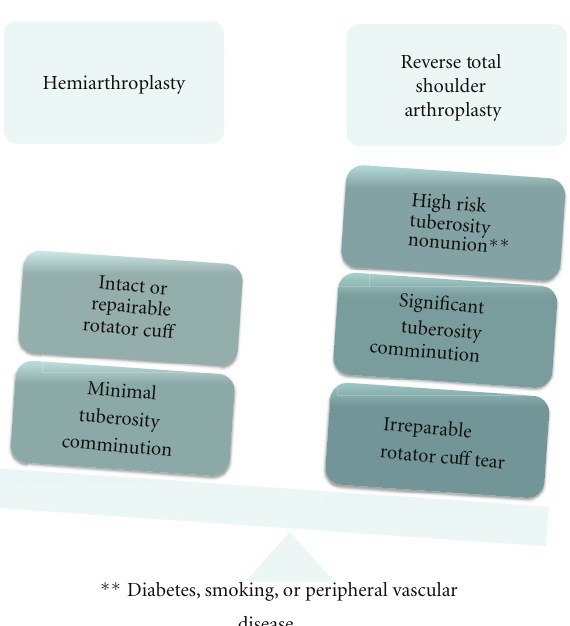
Figure 7: In patients indicated for prosthetic replacement, it is important to consider rotator cu ff competency and risk of tuberosity nonunion. Patient with high risk of tuberosity nonunion (severe comminution, diabetes, smoking, or peripheral vascular disease) may benefit from primary reverse total shoulder